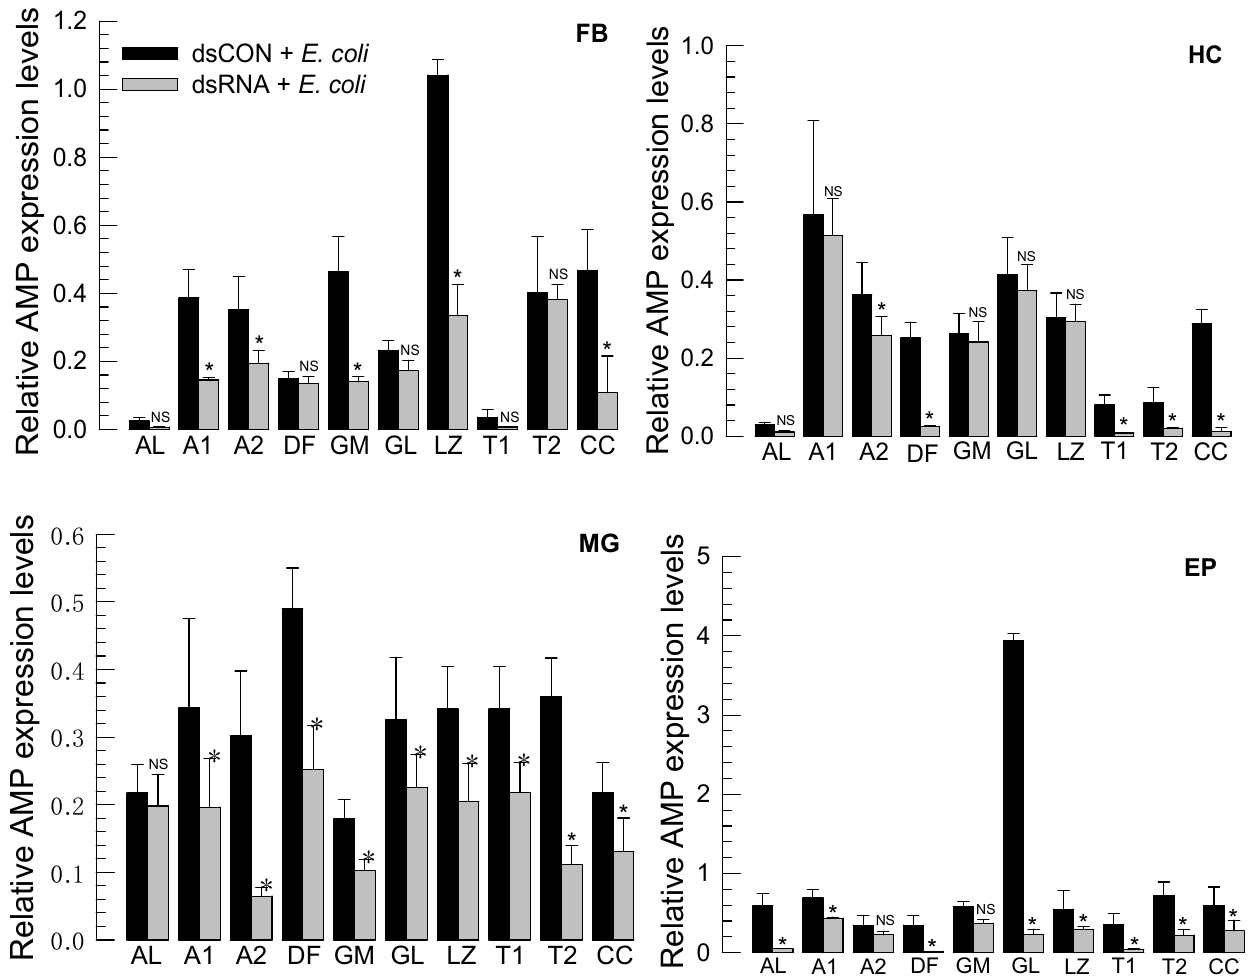
Figure 4. Effect of RNA interference (RNAi) of Repat33 expression on humoral immune responses of L5 larvae of S. exigua . Humoral immune responses were assessed by quantifying expression levels of 10 antimicrobial peptides (AMP) genes: apolipophorin III (‘AL’), attacin 1 (‘A1 (cid:48) ), attacin 2 (‘A2 (cid:48) ), defensin (‘DF’), gallerimycin (‘GM’), gloverin (‘GL’), lysozyme (‘LZ’), transferrin 1 (‘T1 (cid:48) ), transferrin 2 (‘T2 (cid:48) ), and cecropin (‘CC’). L5 larvae were injected with dsRNA (‘dsRepat’, 1 µ g/larva) specific for Repat33 . At 24 h after injection, larvae were injected with E. coli (10 4 cells/larva) and incubated at room temperature for 24 h. Total RNAs were extracted from different tissues [fat body (‘FB’), midgut (‘MG’), hemocyte (‘HC’), and epidermis (‘EP’)] and used for constructing cDNAs. A GFP gene was used to construct control dsRNA (‘dsCON’). Each treatment was replicated three times with independent tissue preparations. A ribosomal protein gene, RL32 , was used as an internal control for RT-qPCR. Each treatment was replicated three times. Asterisks indicate significant differences exist ( p <